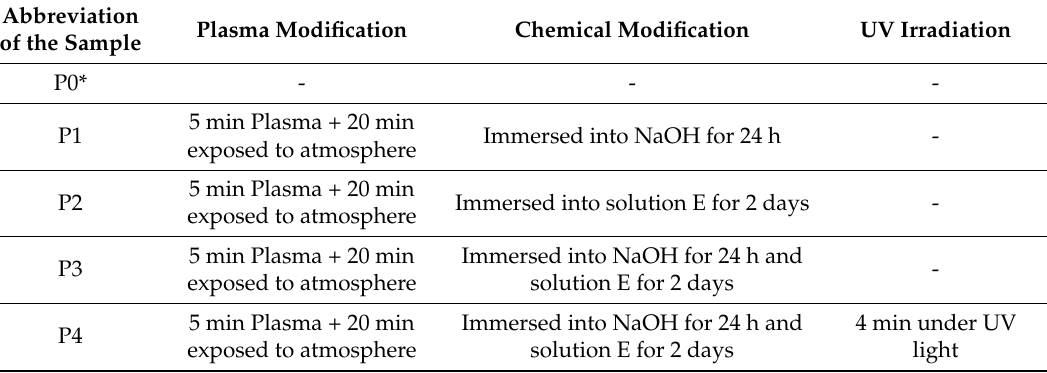
Table 1. Preparation of nanofibrous composite membranes in various ways for different combinations of plasma and chemical